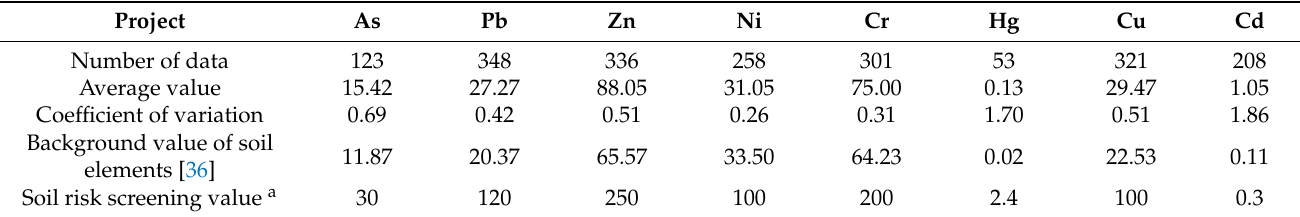
Table 4. Descriptive statistics of heavy metal concentrations/(mg · kg − 1 ).